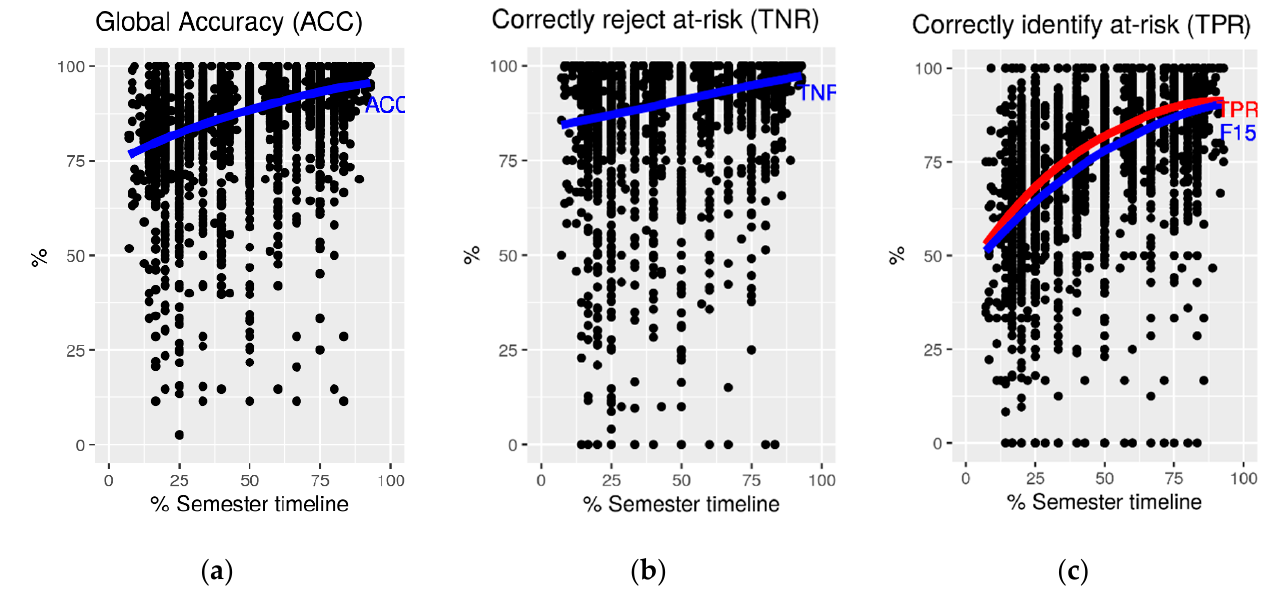
Figure 9. Scatter plots of the PGAR model for ( a ) accuracy; ( b ) TNR ; and ( c ) TPR , F 1.5. Table 3. LOESS regression of the PGAR model for ACC , TNR , TPR , and F 1.5 metrics. Semester